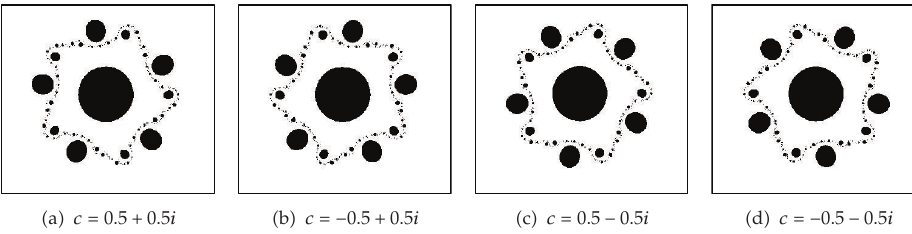
Figure 2: The generalized J sets without any perturbation when α (cid:6) −